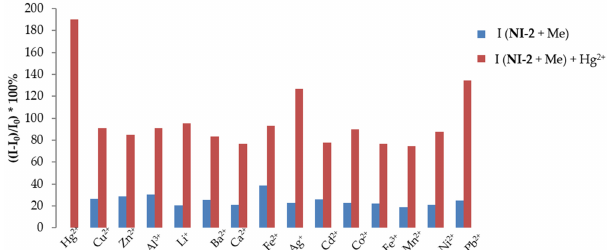
Figure 11. Relative fluorescence intensity changes at 525 nm of NI-2 (6.54 × 10 − 6 M) in MeOH/buffer solution ( v / v , 1/2, pH 5.5) after addition of 150 µ L stock solution of Hg 2+ and other metal ions after 5 min from the addition of Hg 2+ ions. The concentrations of Hg 2+ ions and competing metal ions are equal (4.55 × 10 − 5 M).